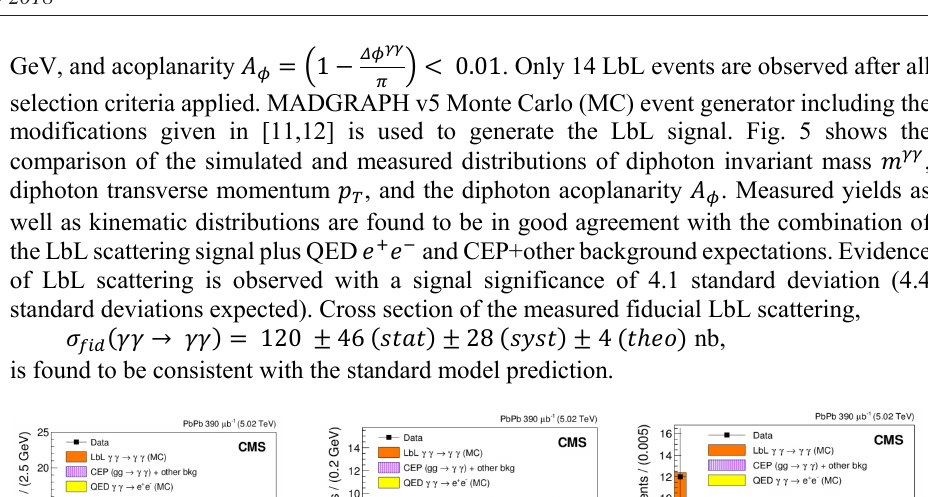
(middle), and 𝑝𝑝 𝑇𝑇